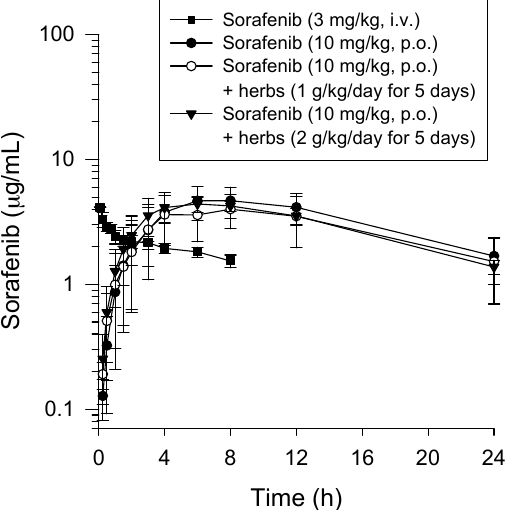
Figure 1. Time-concentration profiles of sorafenib in rat plasma from Group A1 ( ▪ ): sorafenib (3 mg/kg, i.v.); Group A2 ( ● ): sorafenib (10 mg/kg, p.o.); Group A3 ( ○ ): pretreated with the Long-Dan-Xie-Gan-Tang (LDXGT) formulation (1 g/kg/day, p.o.) for five consecutive days followed